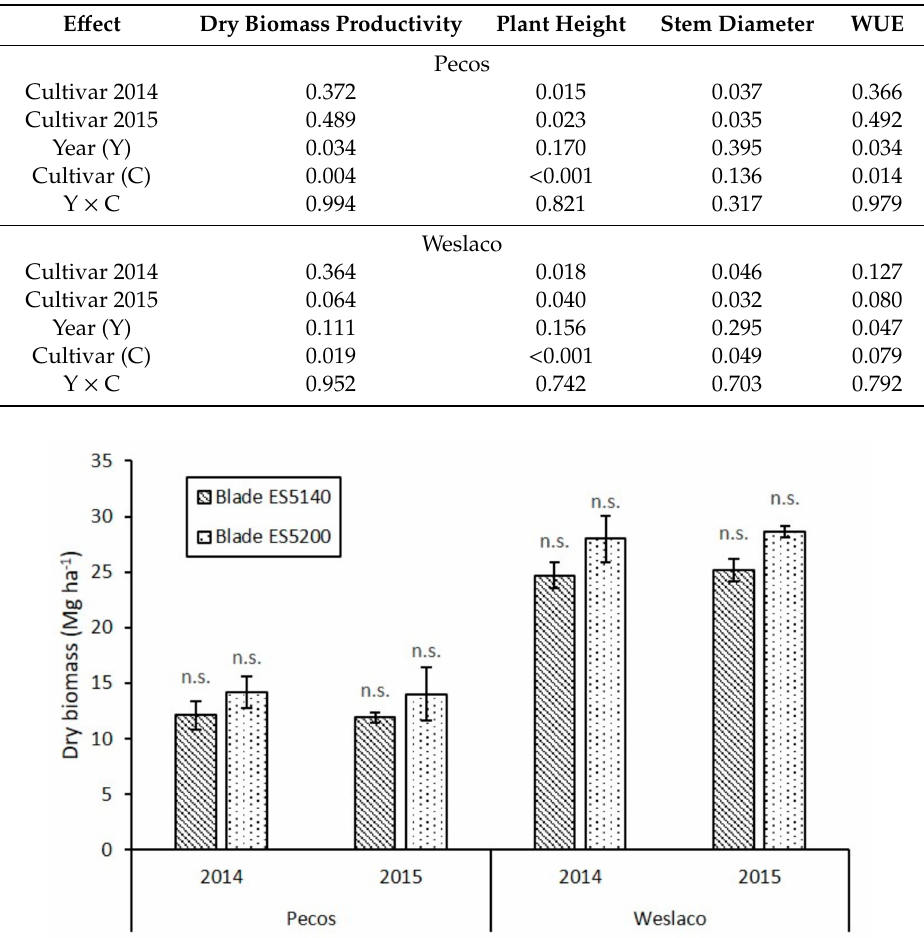
Figure 3. Dry biomass productivity at the end of each growing season for the two energy sorghum cultivars; n.s. = not